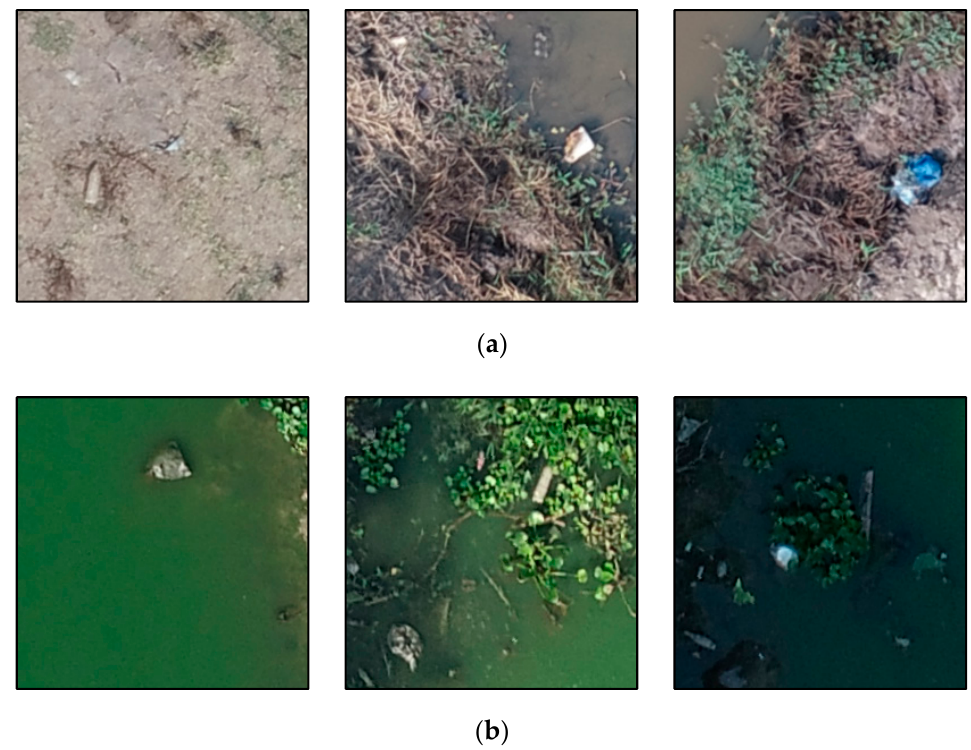
Figure 5. Sample images from datasets used for training deep learning models for plastic detection Sample images from datasets used for training deep learning models for plas- in rivers. ( a ) HMH in Laos with co-ordinates (887,503.069 m, 1,995,416.74 m); (887,501.986 m, tic detection in rivers. ( a ) HMH in Laos with co-ordinates (887,503.069 m, 1,995,416.74